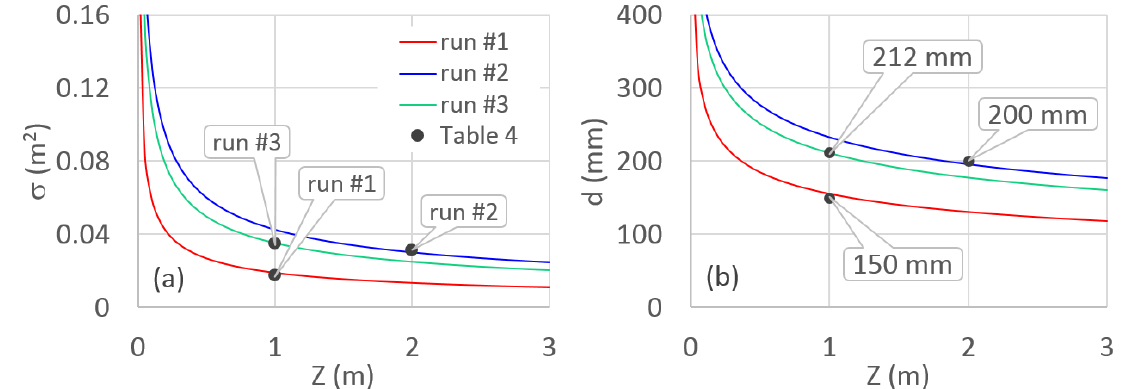
Figure 5. Relationship between (a) the hole’s cross sectional area and (b) the corresponding hole diameter, d , versus the tank height, Z . Black dots refer to the applications for the three runs.